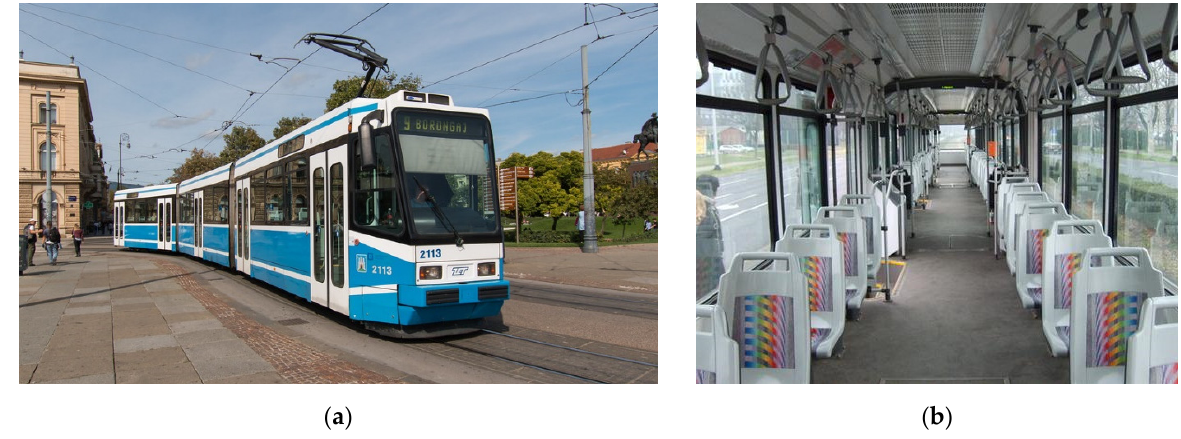
Figure 4. Tram vehicle TMK2100: ( a ) exterior; ( b ) interior.